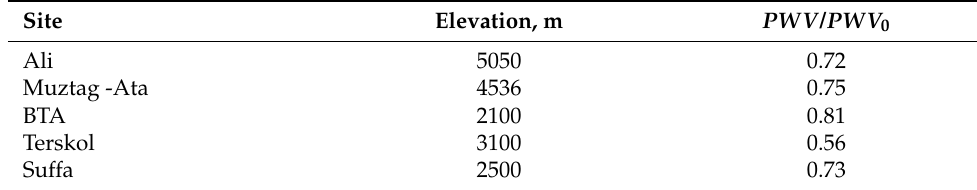
Table 7. Mean ratios of precipitable water vapor at the summit to the PWV values corresponding to the “surrounding terrain” K 0 at the sites of Ali, Muztag-Ata, Suffa, Bta and Peak Terskol.